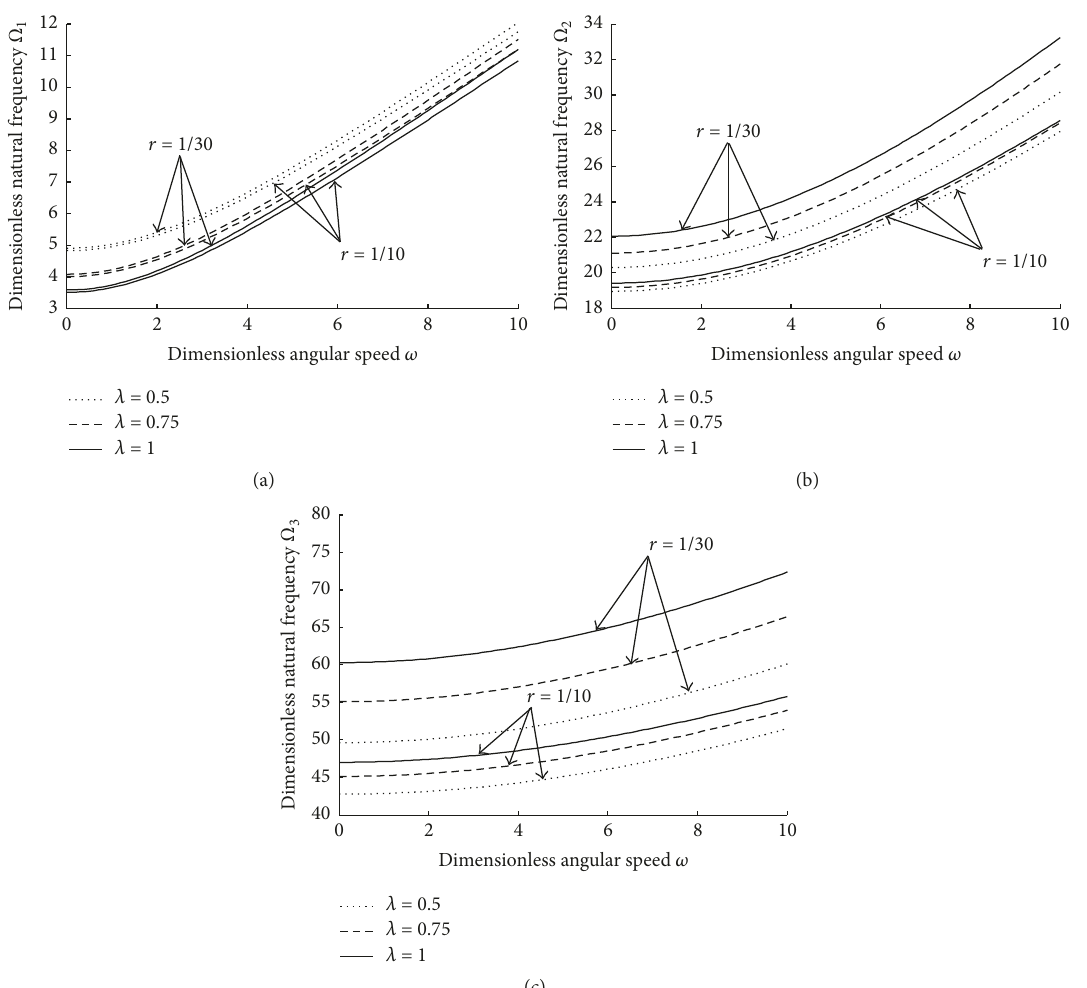
Figure 9: Variation of the first three dimensionless natural frequencies of rotating tapered hollow beam with dimensionless angular speed of the hub for different values of 𝜆 = 0.5 , 0.75 and 𝑟 = 1/30 , 1/10 at 𝑟 0 = 0 , 𝛽 = 0.2 : (a) 1st mode; (b) 2nd mode; and (c) 3rd mode.